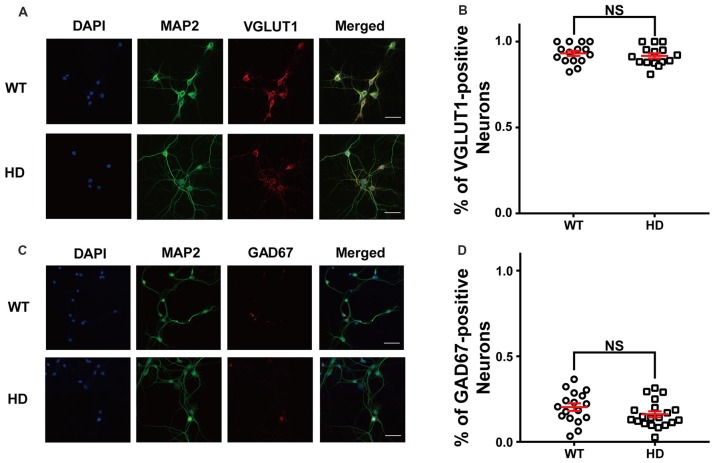
The majority of cultured cortical neurons are excitatory. (A) Representative confocal images of wild-type (WT) and Huntington’s disease (HD) cultured cortical neurons isolated from WT and heterozygous zQ175 mice immunostained for microtubule-associated protein 2 (MAP2; green) and vesicular glutamate transporter 1 (VGLUT1; an excitatory neuronal marker; red); the nuclei were counterstained with DAPI (blue). The scale bar represents 40 μm. (B) The percent of VGLUT1-positive neurons in WT and HD cortical neurons. The percentage of VGLUT1-positive neurons were higher than 90% regardless of genotype, indicating that the vast majority of neurons are excitatory. The percentage between WT and HD showed no significant differences (p = 0.0225, from independent two-tailed Student’s t-test). (C) Representative confocal images of cultured neurons WT and HD cortical neurons immunostained for MAP2 (green) and glutamic acid decarboxylase 67 (GAD67; an inhibitory neuronal marker; red); the nuclei were counterstained with DAPI (blue). Scale bar represents 40 μm. (D) The percent of GAD67-positive neurons in WT and HD neurons. The percentage of GAD67-positive neurons between WT and HD showed no significant differences (p = 0.136; independent two-tailed Student’s t-test). In this and subsequent figures, data are presented as the mean ± SEM. NS, not significant.